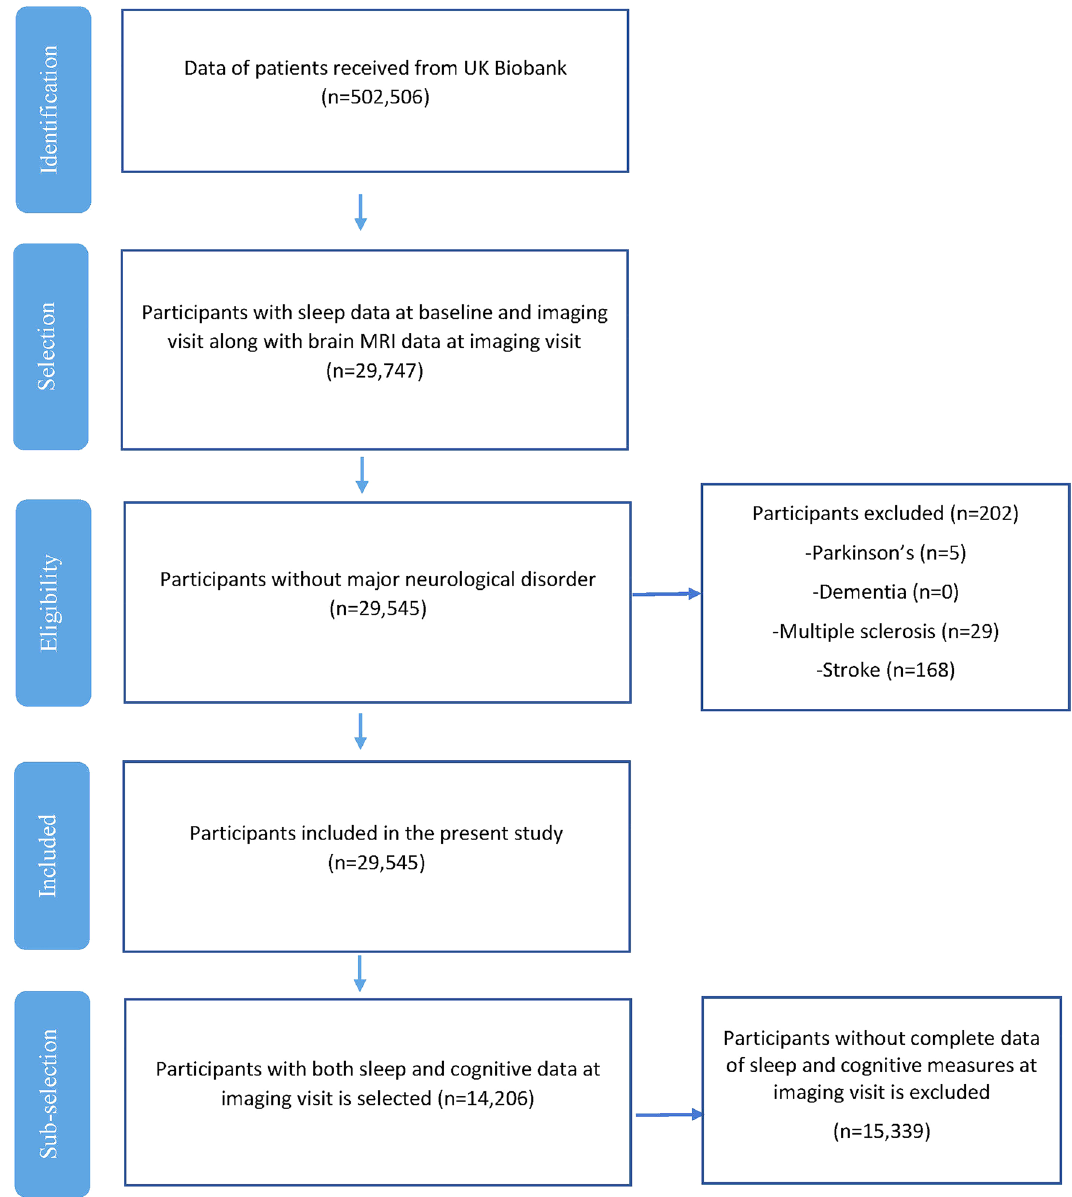
Figure 1. Flow chart of the participants’ selection